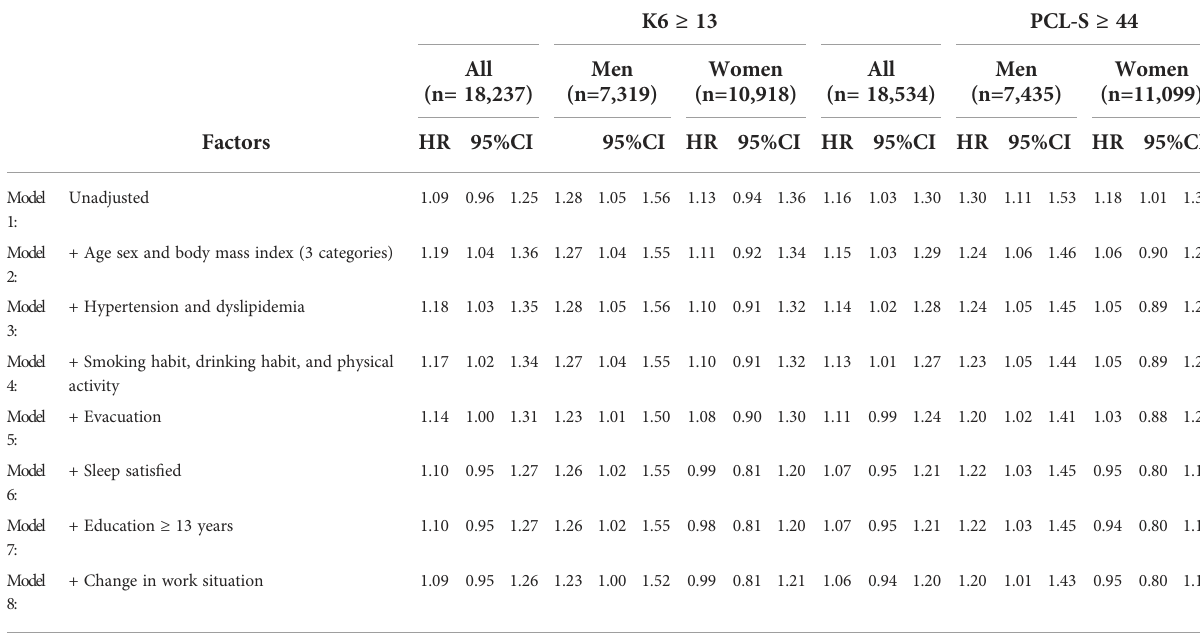
TABLE 3 Hazard ratio of K6 ≥ 13 or PCL-S ≥ 44 for new onset diabetes